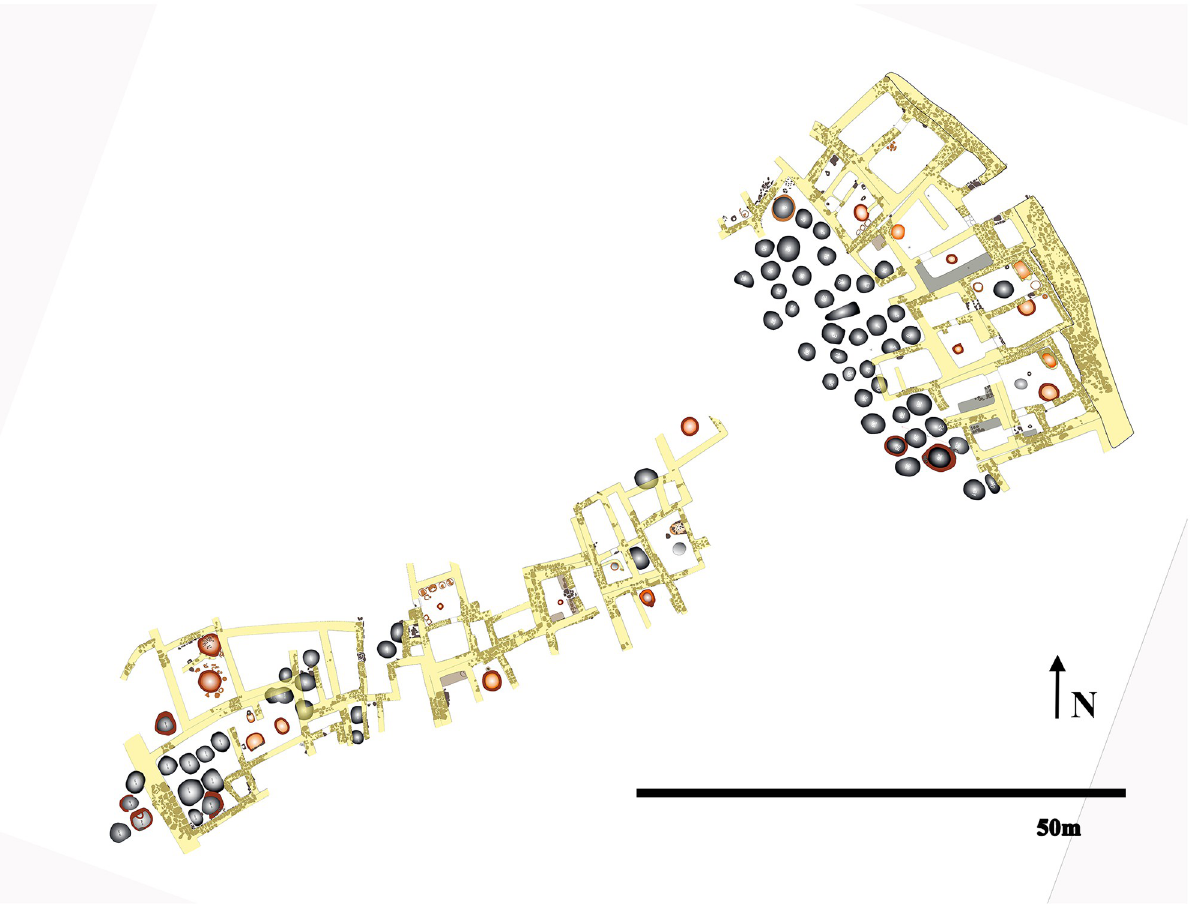
Fig 4. Architectural plan of the Resulo ğ lu settlement ( © Resulo ğ luexcavations archive).